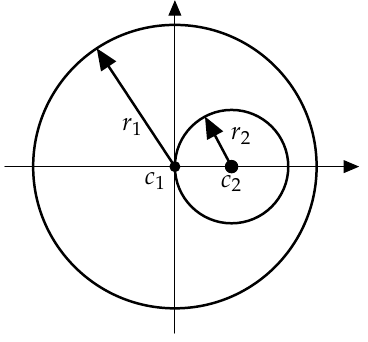
Figure 4. Domain on which an exact solution is computed. The outer boundary is the unit circle. The inner boundary is the circle of center c 2 = 0.4 and of radius r 2 = 0.4. The Dirichlet boundary conditions used are such that the value is c 1 = 0 on the inner boundary and r 1 = 1 on the outer